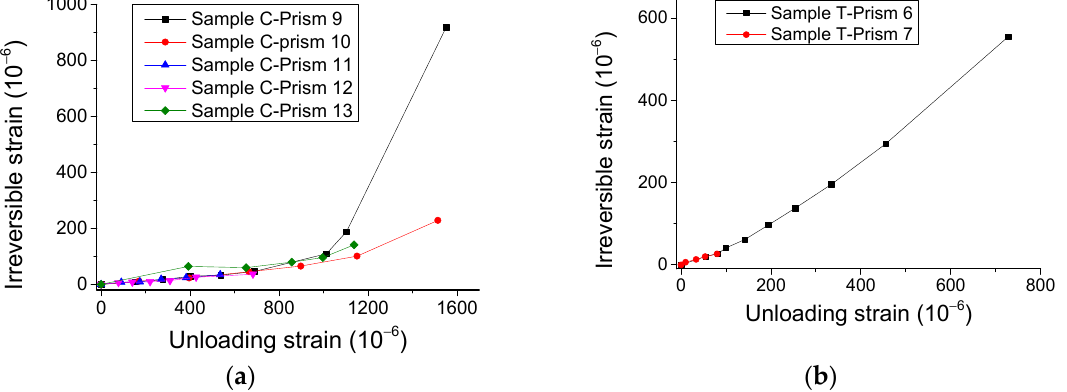
Figure 11. Experimental results of relationship of irreversible strain—unloading strain. ( a ) Compressive case and ( b ) direct tensile case.